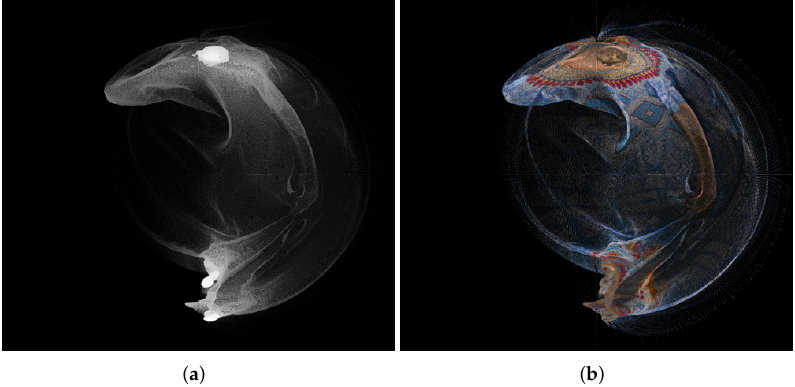
Figure 1. Panorama images created using point cloud “longdress_vox10_1060.ply” from the Lambert azimuthal equal-area projection, for the geometry ( a ) and texture ( b